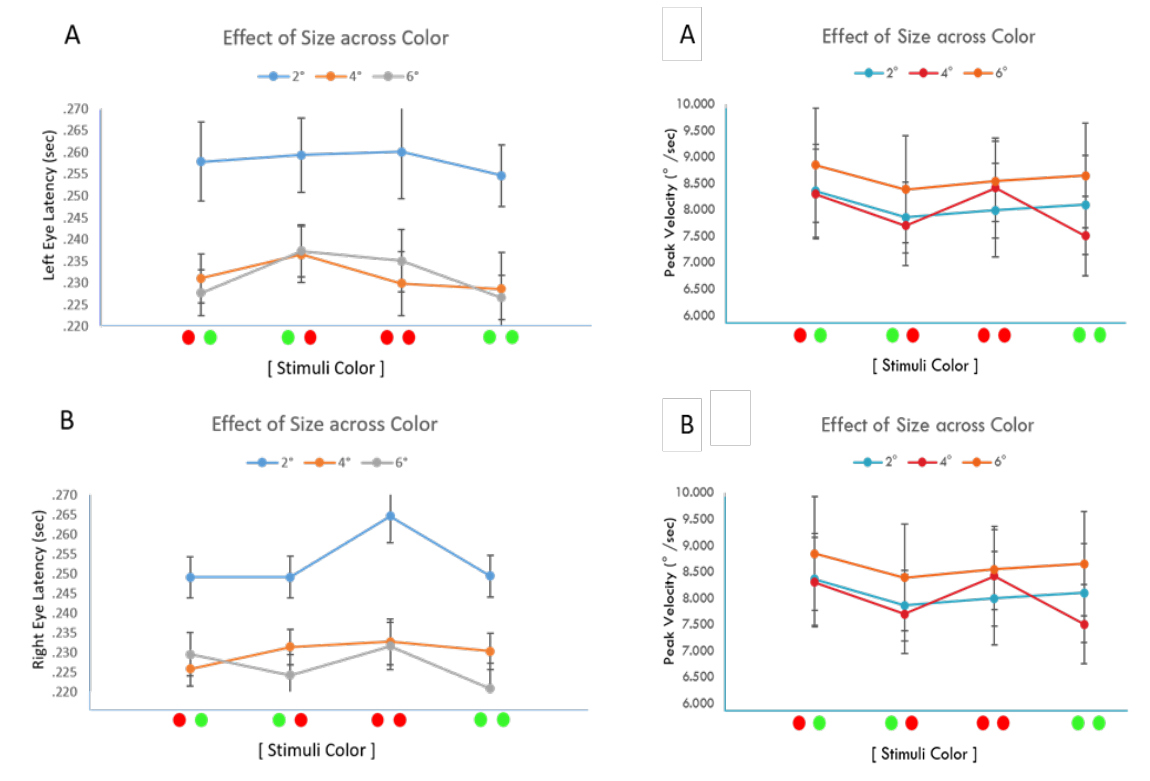
Figure 3: The effect of stimulus target type across color for (A) the left eye response latency and (B) right eye response latency.